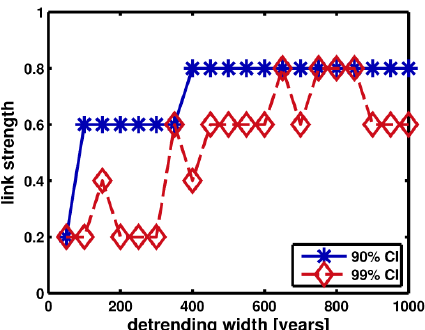
Fig. 9. Sensitivity of the link strength result for the original records of Berkelhammer et al. (2010) and Zhang et al. (2008) to changes in the detrending parameter W of a Gaussian-kernel detrending and the significance level in the hypothesis